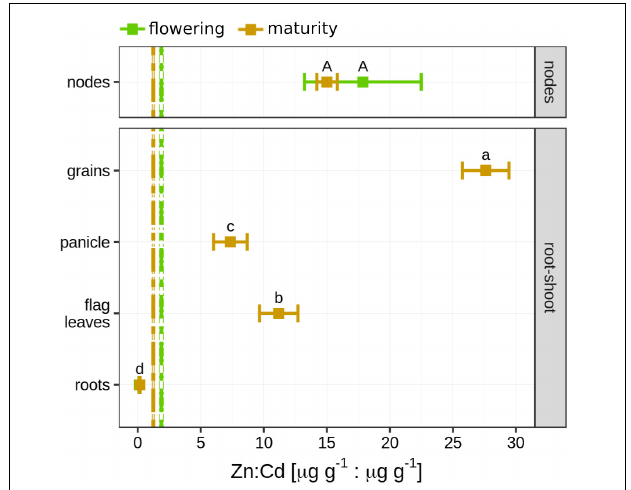
FIGURE 6 | Zn:Cd mass ratios in different plant parts. Error bars denote the standard deviation of n = 4 experimental replicates and letters denote statistical difference of the mean determined using ANOVA (non-transformed). Except for nodes: the standard error denotes 2sd of n = 2 experimental replicates and statistical difference was evaluated visually. Vertical dashed lines denote Zn:Cd mass ratios in the shoot (flowering) and straw (maturity). Thin lines denote the standard deviation (sd) of n = 4 experimental replicates. The Zn:Cd mass ratio of the root at flowering is plotted but not visible since it is identical with the root at